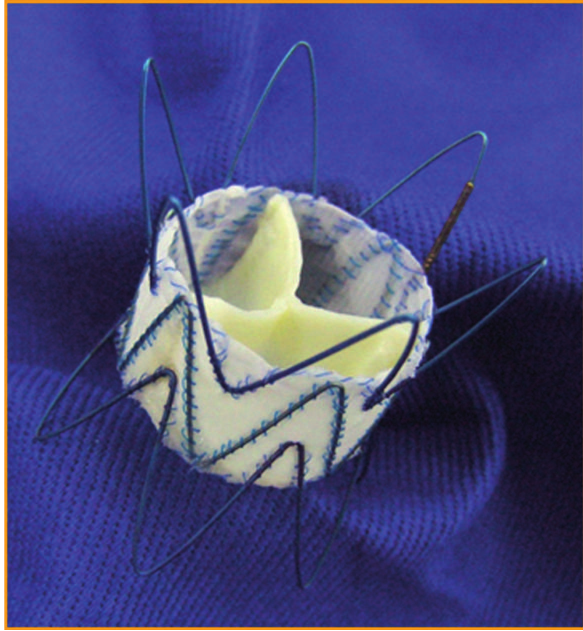
Fig. 1. Prótese valvada de pericárdio bovino revestida de poliéster